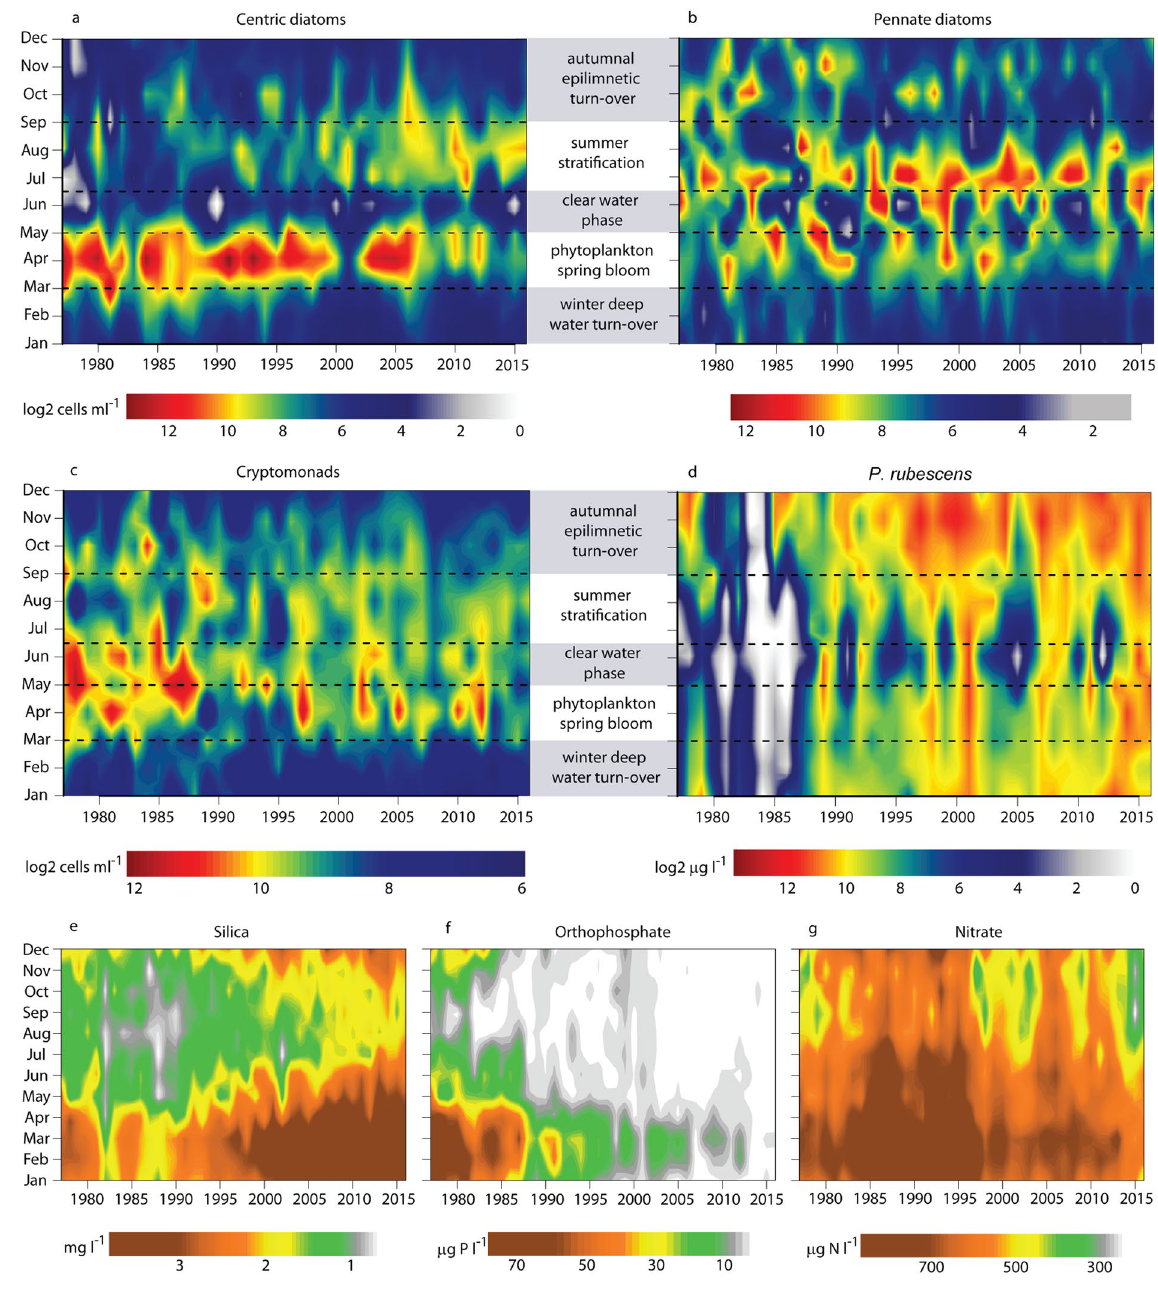
Figure 3. Long-term (1977 to 2016) trends in seasonal successions of abundant algae and their potentially limiting substrates. (a) Abundances of centric diatoms, ( b ) pennate diatoms, ( c ) cryptophytes, ( d ) and biomass of Planktothrix rubescens ( n = 480 for all parameters) during characteristic phenological phases (gray-white boxes). Classification of phases followed the terminology of the Plankton Ecology Group (PEG) model published by Sommer et al . 15 . Epilimnetic (0–20 m) concentrations of ( e ) silica, ( f ) orthophosphate-P and ( g ) nitrate-N ( n = 480 for each parameter). All parameters were calculated as depth-volume weighted averages for the water column between 0 and 20 m